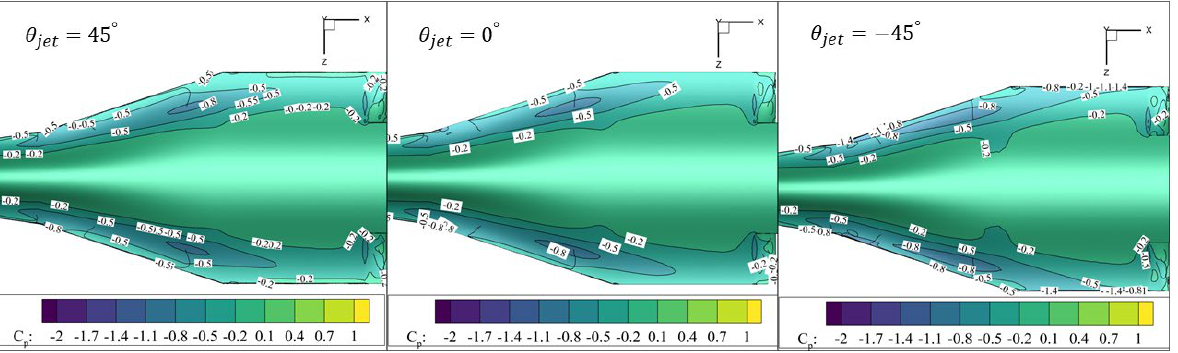
Figure 22. Comparison of the pressure coefficient distributions at the cross-sections for different blowing directions at α = 10 ◦ . ( a ) x / L 0 = 0.5; ( b ) x / L 0 = 0.6; ( c ) x / L 0 = 0.75; ( d ) x / L 0 = 0.8.